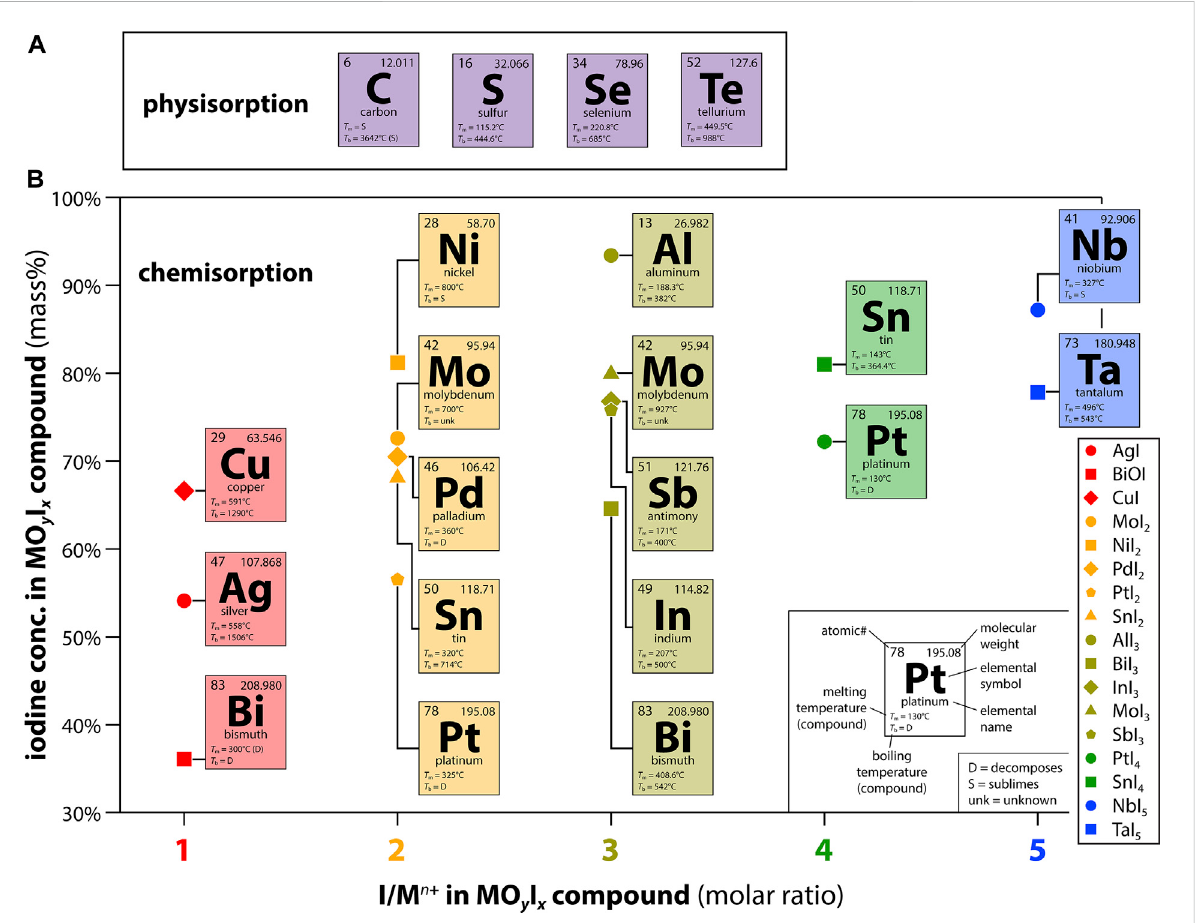
FIGURE 2 Summaryofcommonspeciesdemonstratedintheliteraturefor (A) physisorption-basedor (B)